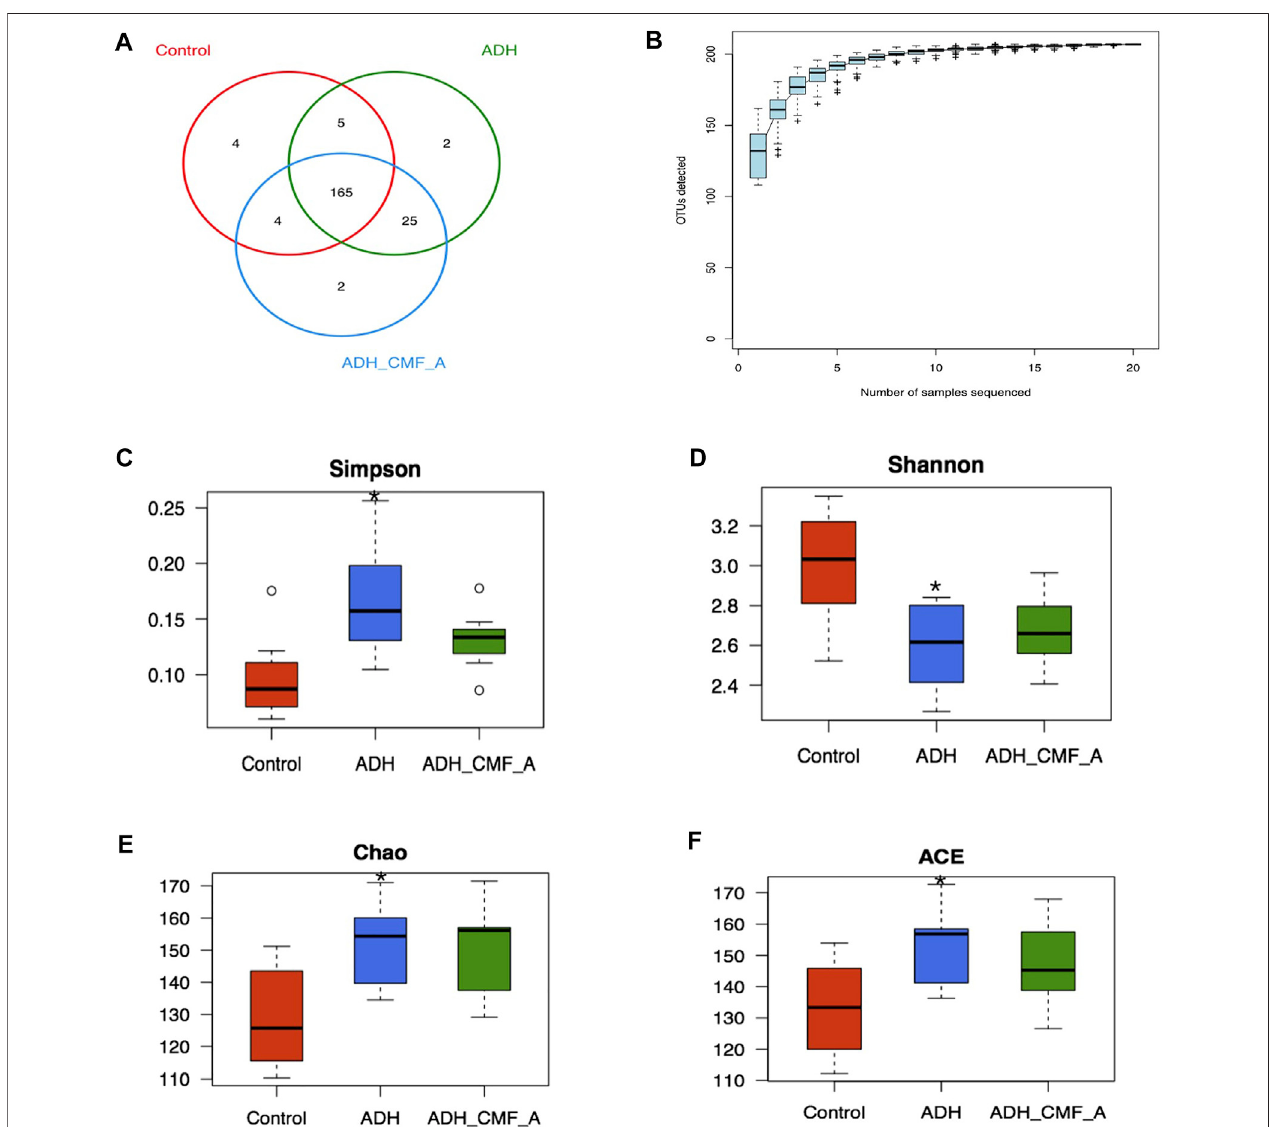
FIGURE 7 | Effects of CMF on the structure and diversity of intestinal micro fl ora (A) Venn diagram of OTU distribution differences between groups; (B) Species accumulation curve; (C) Comparison box of Simpson index for diversity; (D) Comparison box of diversity Shannon index; (E) Box chart of diversity Chao index comparison; (F) Box plot of diversity ACE index comparison; Compared with Control mice, * p < 0.05.